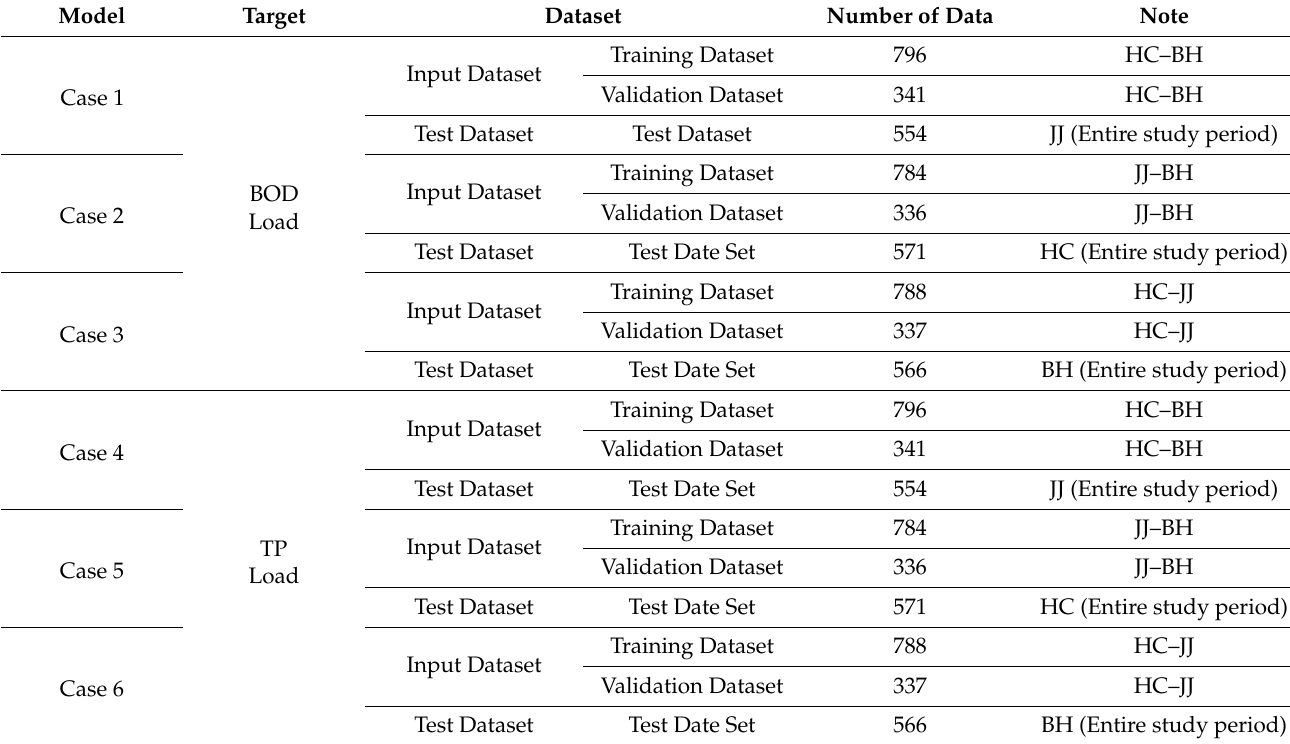
Table 3. Datasets for the CNN model used in this